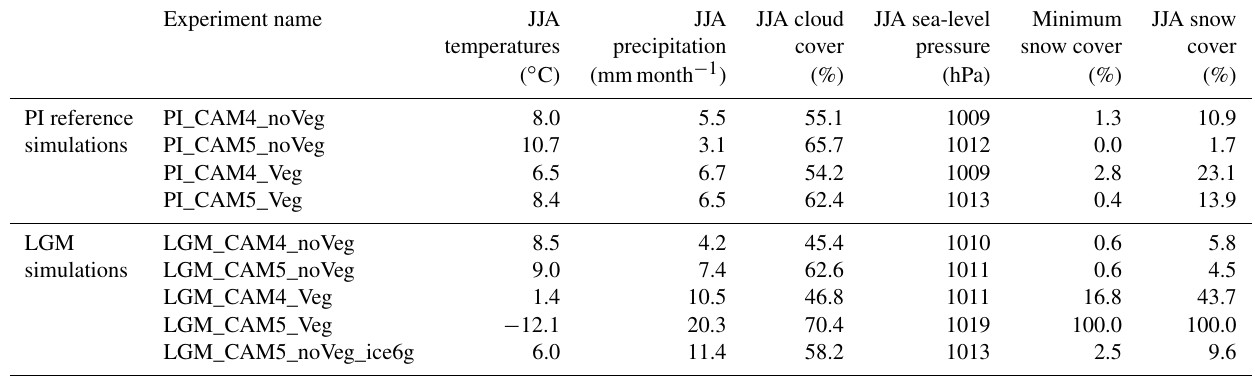
Table 3. Simulated CESM PI and LGM climatic conditions in the Siberian target region. For the abbreviations, see Table 2. Note that LGM JJA sea-level pressure shown here has been corrected for LGM–PI differences in global mean sea-level pressure.